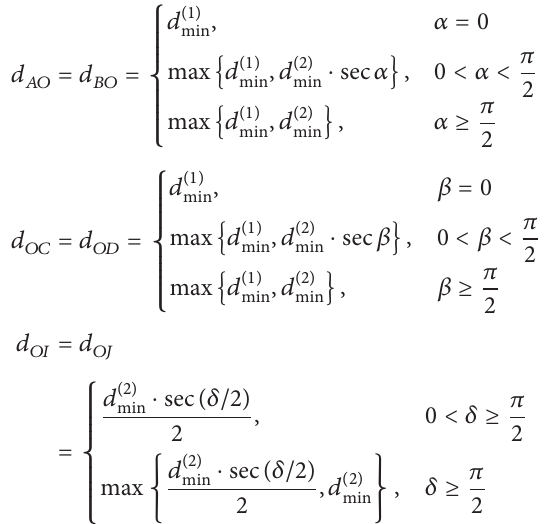
If the lengths of the two sides for protection zones are set as follows, all the above constraints can be satisfied in combination with the conflict-control strategy proposed in next